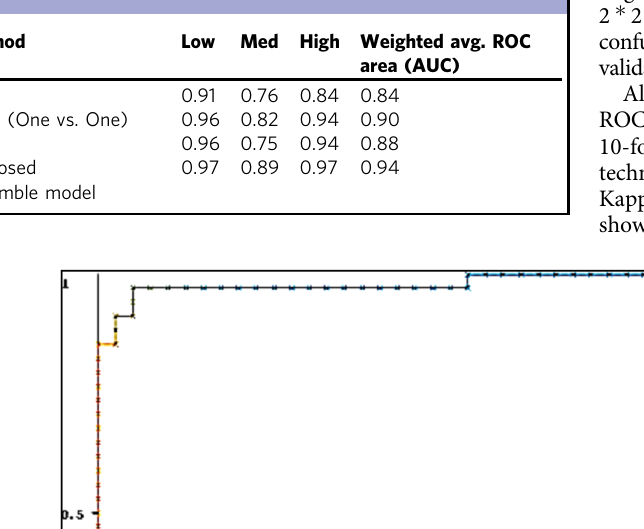
Table 7 Class-wise AUC comparison of proposed soft voting ensemble model with standard classi fi ers for detection of juvenile delinquency.